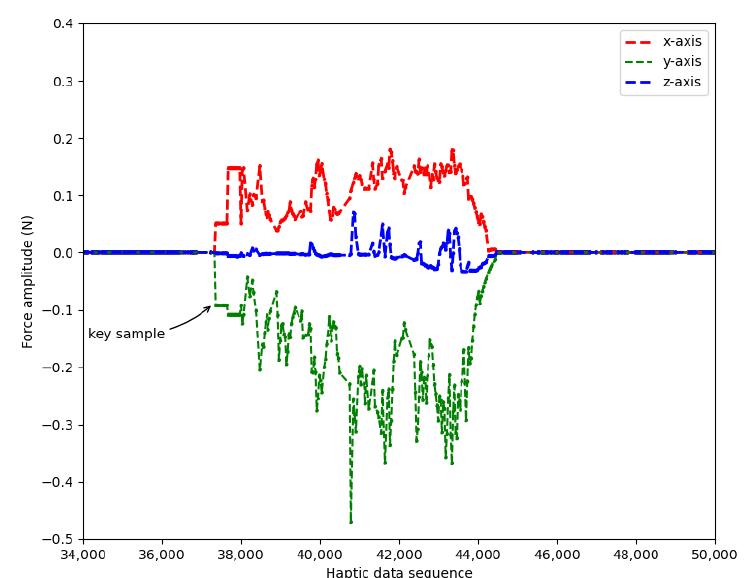
Figure 4. An example of key sample